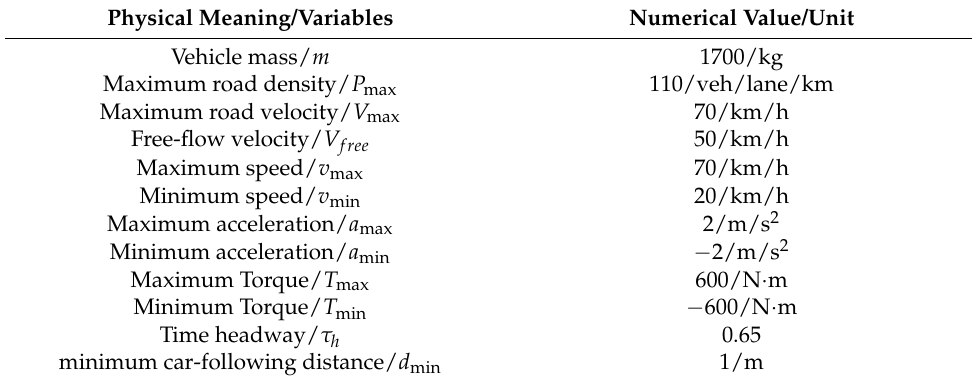
Table 1. System model